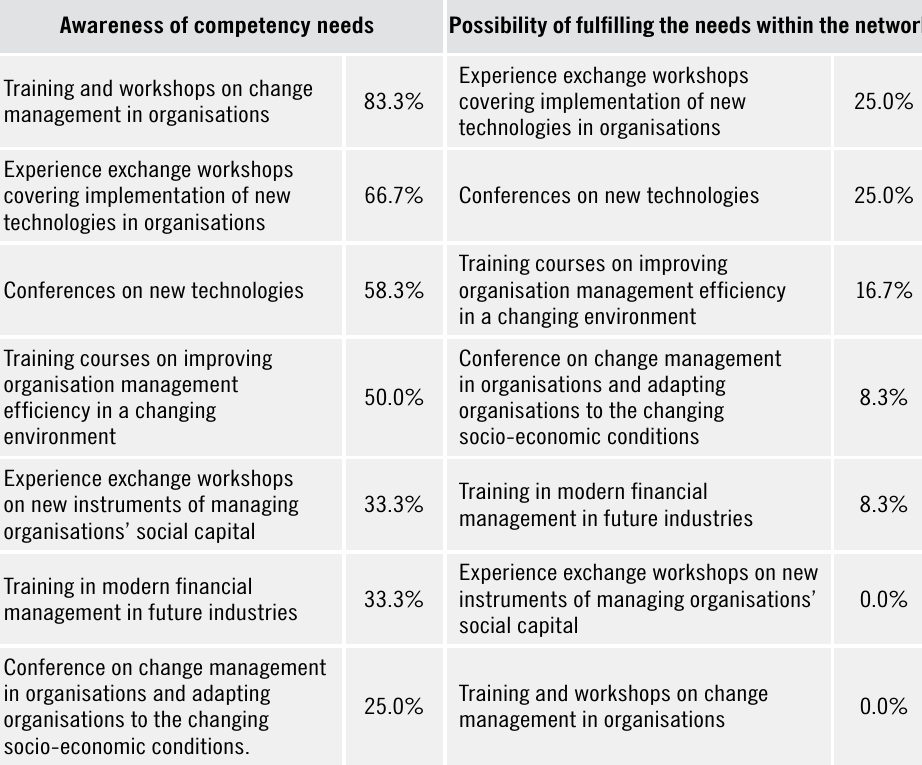
Table 3. Competency need awareness among companies in terms of specialist training services and the possibility of satisfying such needs – IDI